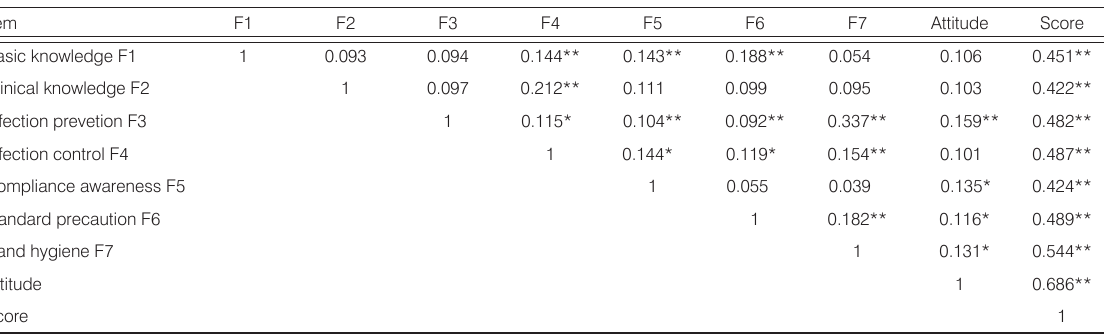
Table 9. Correlation analysis between each variable and the questionnaire ( N = 681).